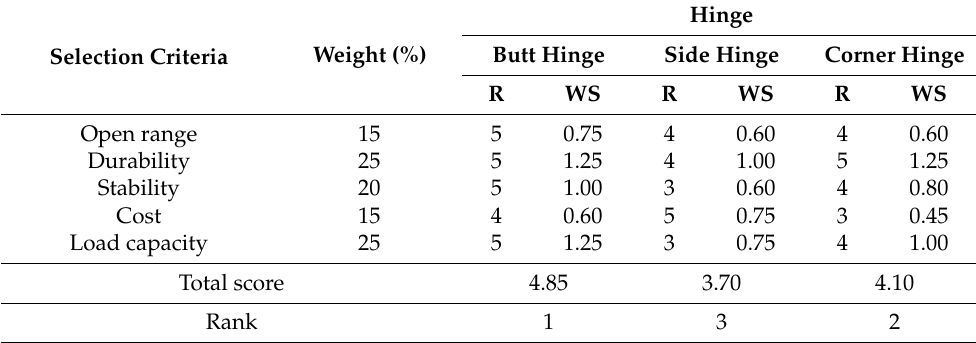
Table 6. Scoring of